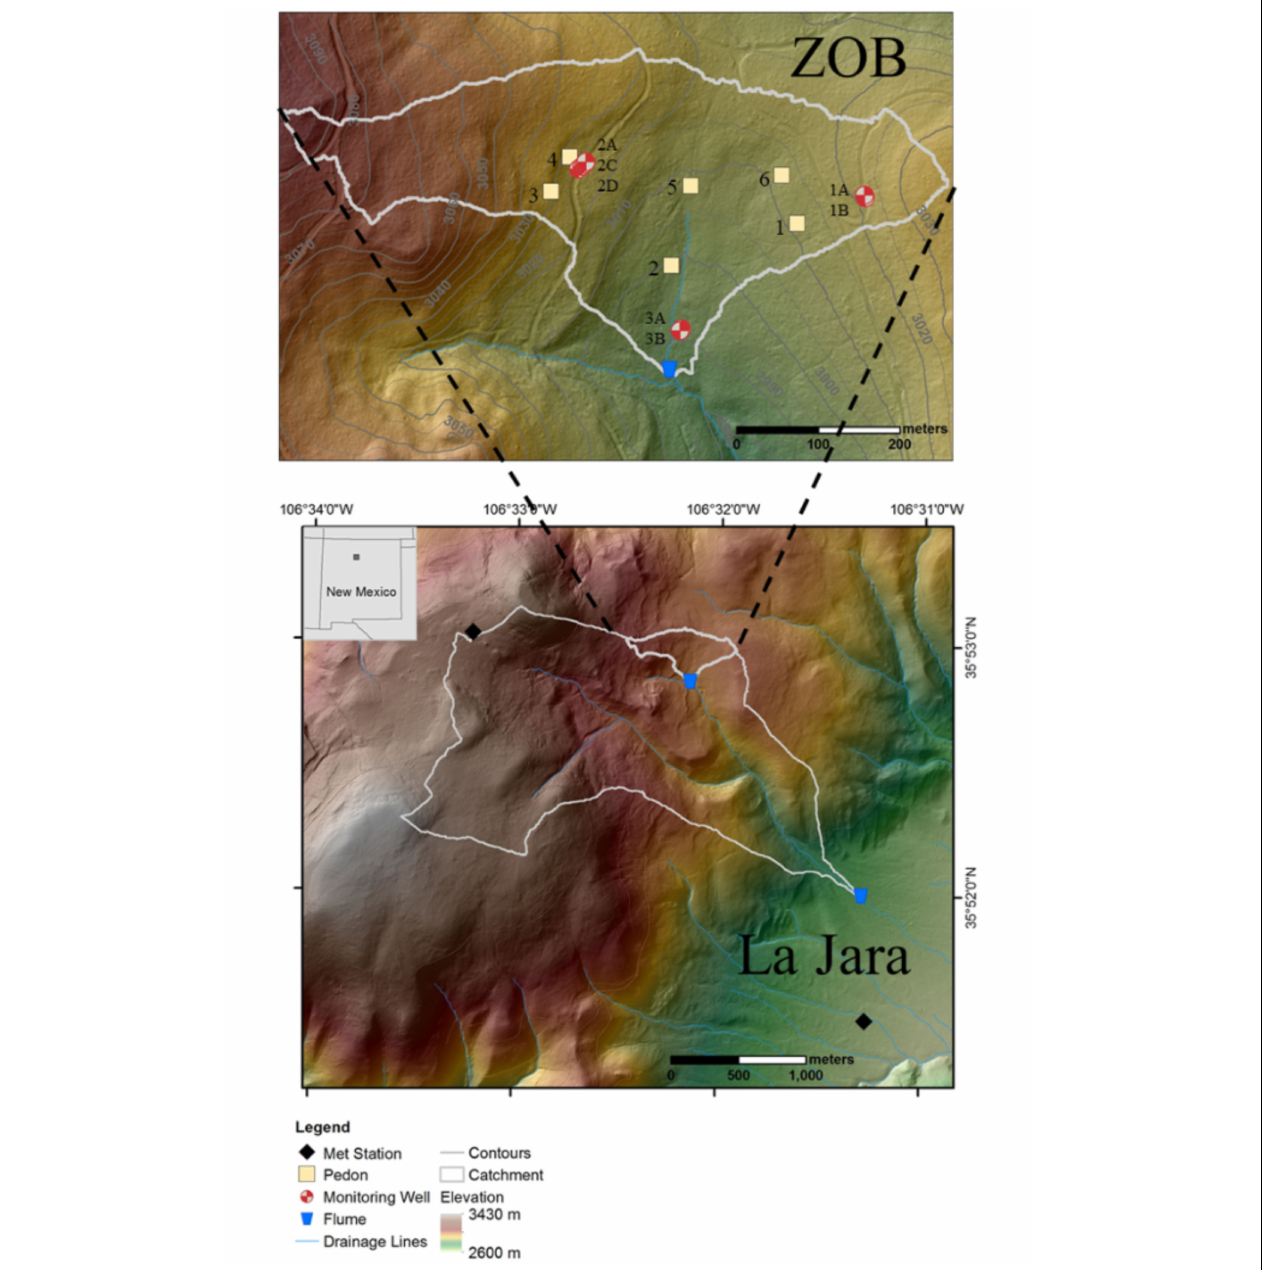
FIGURE 1 | Digital elevation model (DEM) of the La Jara catchment (LJ, outline in white) based on 2010 LiDAR flight data. LJ drains the southeastern slope of Redondo Peak within the Valles Caldera National Preserve. The mixed conifer zero order basin (ZOB, also outlined in white and shown in expanded form in upper inset), is an instrumented sub-catchment nested within the LJ catchment. Sampling locations of meteorological stations, flumes, instrumented pedons and groundwater monitoring wells are indicated.